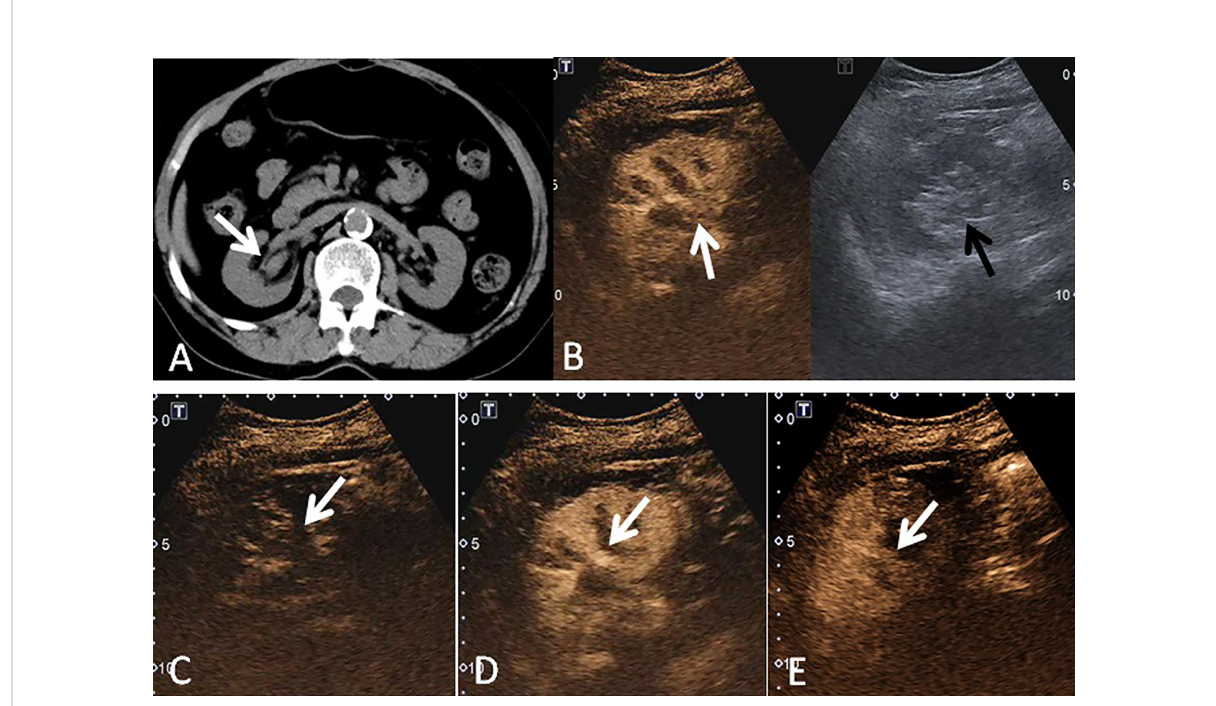
FIGURE 2 A 69-year-old woman had a UCRP in the right kidney with the size of 2.2 × 1.6 cm. (A) A suspicious renal pelvis mass (white arrow) was observed on non-enhanced CT scan. (B) According to the position displayed on CT, the simultaneous display mode of CUS (right) and CEUS (left) was performed, and CEUS demonstrated local contrast enhancement in the renal pelvis (white arrow). CUS showed a slight separation of the renal pelvis, but no lesion was observed (black arrow). (C) On CEUS imaging, it showed a slow-in pattern compared to the renal cortex (white arrow). (D) The enhancement intensity of the tumor was similar to that of the adjacent renal cortex (white arrow). (E) Compared to the renal cortex, the tumor showed a fast-out pattern (white arrow) on